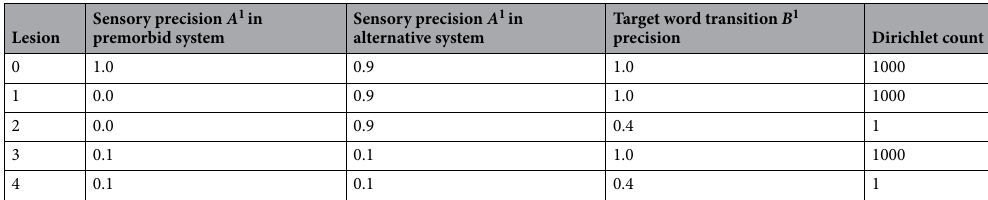
Table 1. Overview of precision manipulation. The table presents a breakdown of the five models and the underlying changes in precision that simulated particular lesion types—and the initial Dirichlet counts. 1 denotes high precision, 0 low precision (i.e., a uniform distribution) and everything else a gradation between the